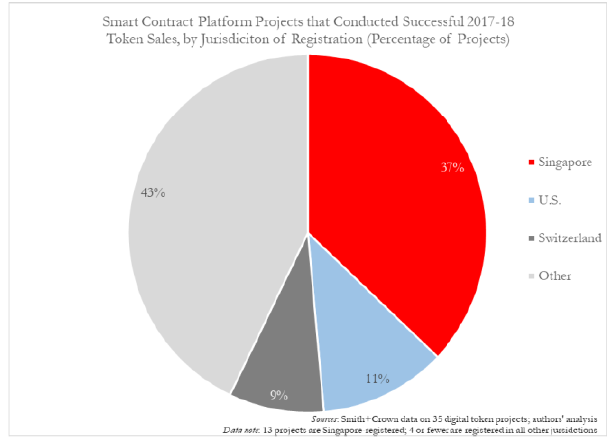
Figure 4. Nearly 40 percent of smart contract platform projects that conducted successful 2017-18 token sales are registered in